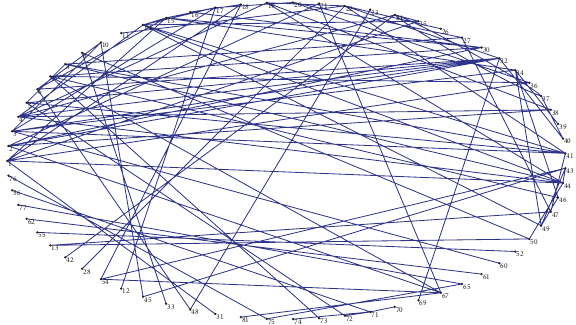
Figure 5: The future partition of crime networks at 4 ∗ Δ𝑡